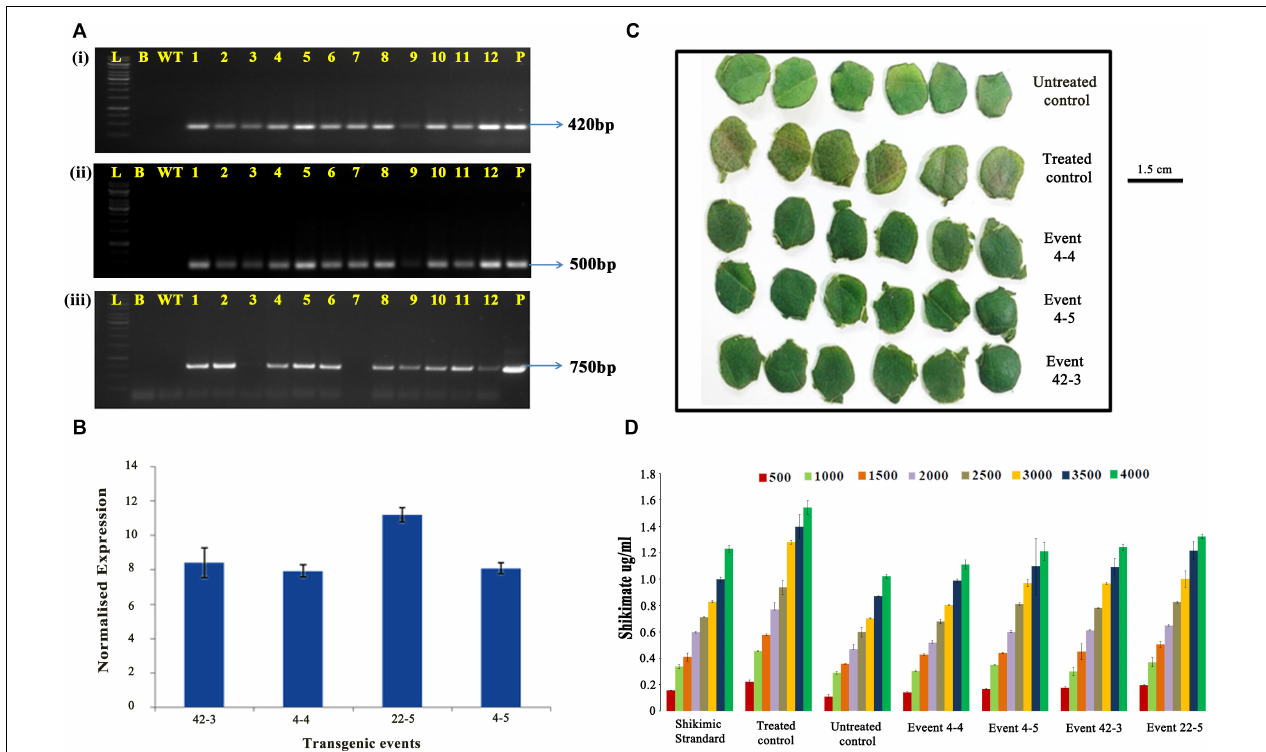
FIGURE 6 | Characterization of cotton transformants in T2 generation. (A) Polymerase chain reaction analysis of T 2 generation plants for the amplification of panel (i) 420-bp CP4-EPSPS fragment, (ii) 500-bp right border region of T-DNA, and (iii) 750-bp nptII fragment. Lane L: 1 kb ladder (Thermo Fisher Scientific); Lane B: template blank; Lane WT: wild type; Lane 1-12: transgenic plants (three lanes each of events 4-4, 4-5, 42-3, and 22-5); Lane P: positive control (modified CP4-EPSPS vector). (B) Quantitative RT-PCR analysis of transgenic plants for transcript accumulation of modified CP4-EPSPS . (C,D) Estimation of shikimate accumulation in the transgenic plants vis-à-vis wild type. (C) Representative picture showing the response of leaf discs treated with 3,000 mg/L glyphosate taken for shikimate assay. (D) Graphical representation of shikimate accumulation in transgenic events vis-à-vis wild type incubated with different concentration of glyphosate for 96